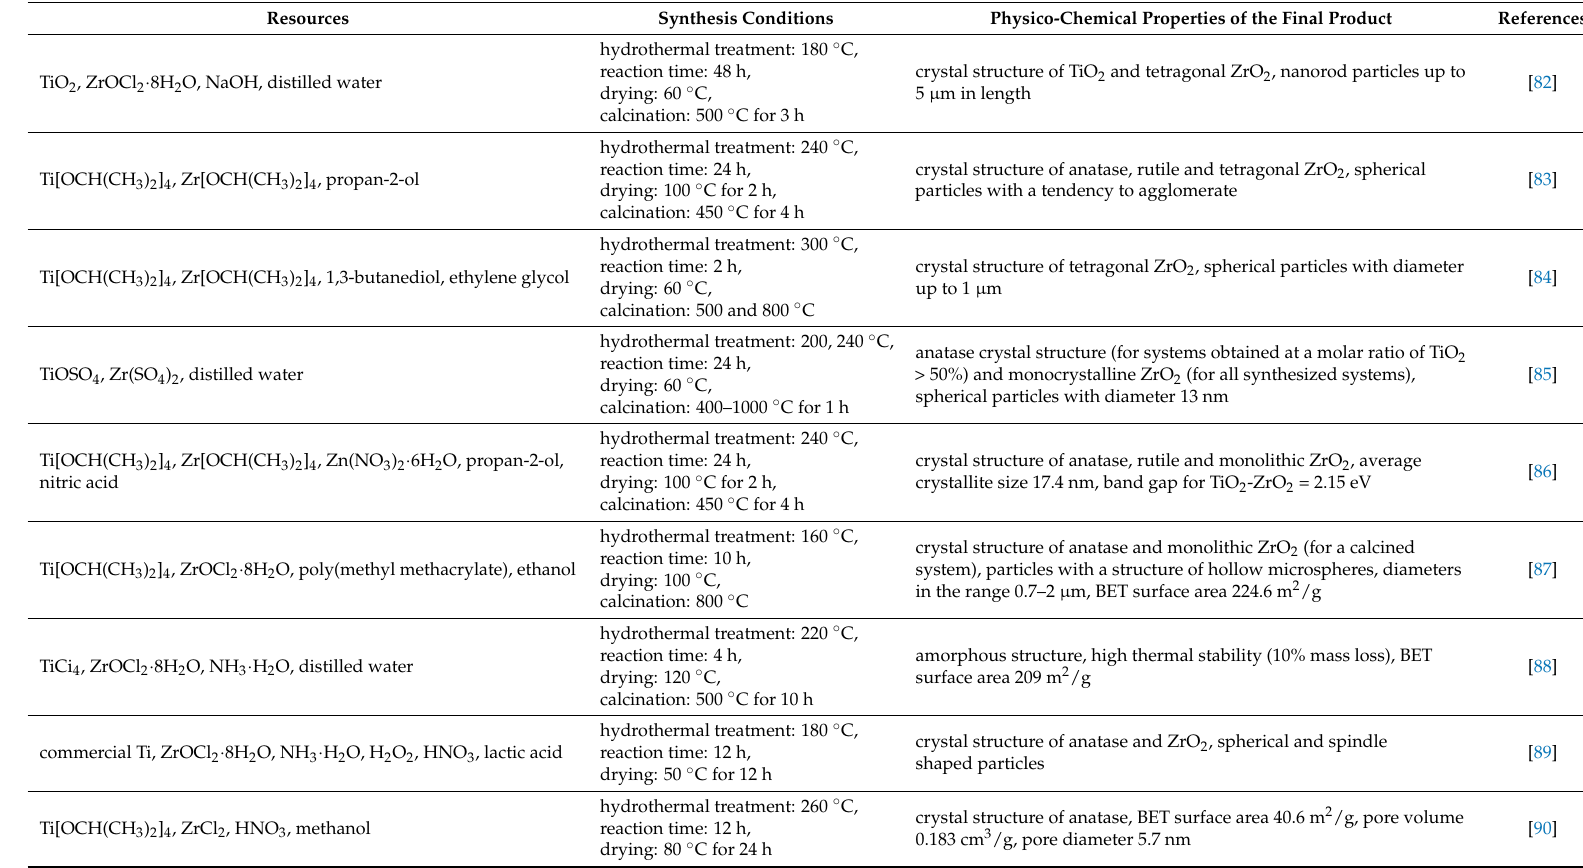
Table 2. Resources, synthesis conditions and physico-chemical properties of TiO 2 -ZrO 2 oxide systems obtained by the hydrothermal